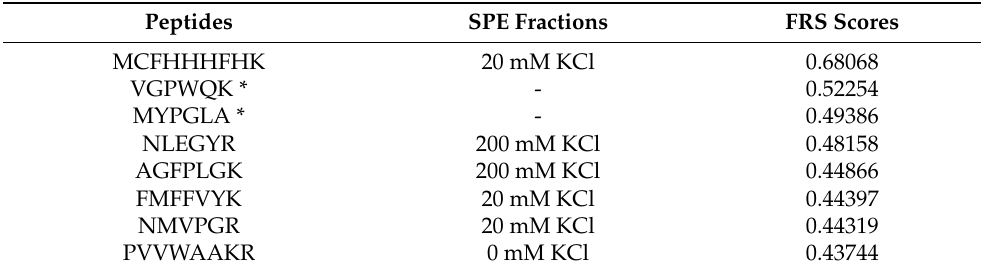
Table 2. Free radical scavenger (FRS) scores of corn silk peptides were identified from the three SPE fractions, in comparison with reference